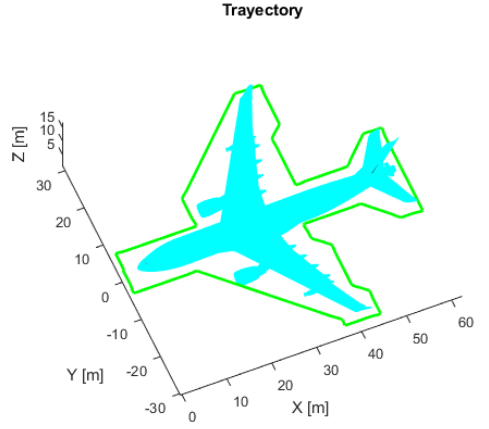
Figure 3. Proposed inspection trajectory (green). Three-dimensional CAD model